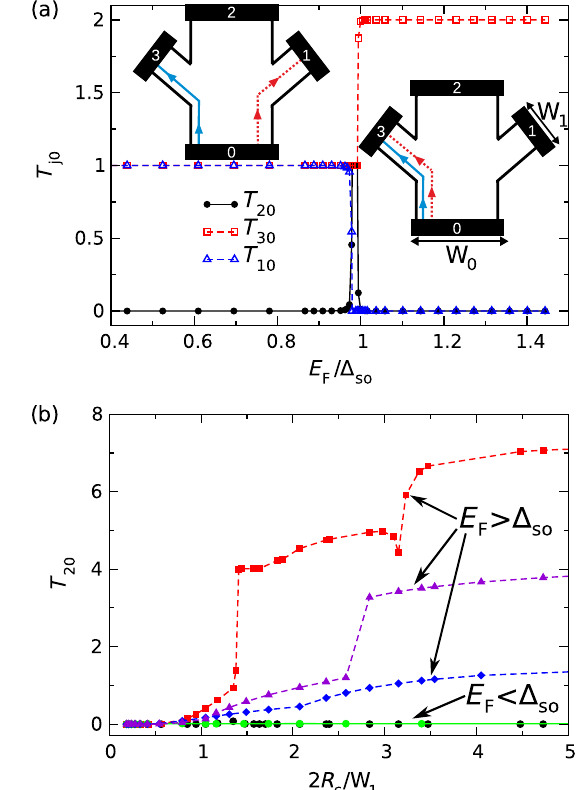
FIG. 3. QSH-QH transition in a four-terminal (cid:3) -shape geome- try. (a) Dimensionless differential conductance from lead 0, where the current is injected, to outgoing leads 1, 2, and 3 in the geometry depicted in the inset, as a function of the Fermi ffiffiffi p ¼ 0 : 02 , l B ’ 8 , and lead widths W ¼ 64 3 , energy ( (cid:1) ffiffiffi p so 0 W ¼ 22 3 ). Below the SO gap, current is carried by QSH 1 edge states, which propagate on different edges (left inset), while above the SO gap it is carried by QH edge states, which propagate on the same edge (right inset). (b) Dimensionless differential conductance from lead 0 to lead 2 as a function of [same values of (cid:1) , W , and W the classical cyclotron radius R c so 0 1 < (cid:2) as in (a)]. Circular symbols correspond to data with E , F so while other symbols (dashed lines) correspond to data with > (cid:2) E ¼ 1 : 06 (blue diamonds); : respectively, E F = (cid:2) F so so = (cid:2) = (cid:2) E ¼ 1 : 25 (violet triangles); and E ¼ 1 : 44 (red F so F so squares). While this direct transmission is vanishingly small and independent of the magnetic field below the SO gap, it and E above the SO gap. The latter increases with both R c F * W , situation arises because the QH phase is destroyed as 2 R c 1 and because the number of transmitting channels increases with E l B and F